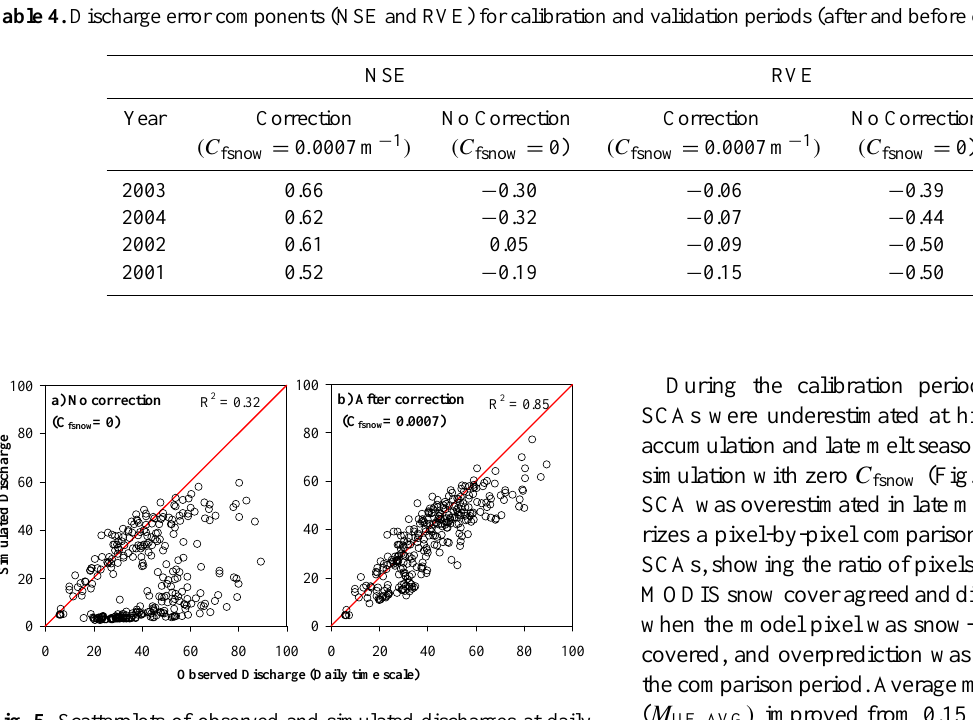
Fig. 5. Scatterplots of observed and simulated discharges at daily time step for 2001–2004. Panel (a) shows results for C fsnow = 0, and panel (b) those for optimised C fsnow